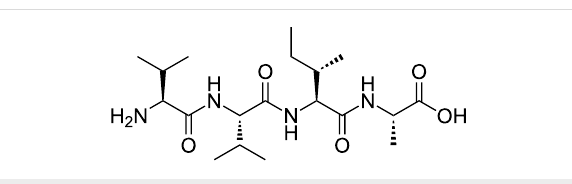
Figure 1: Structure of the VVIA